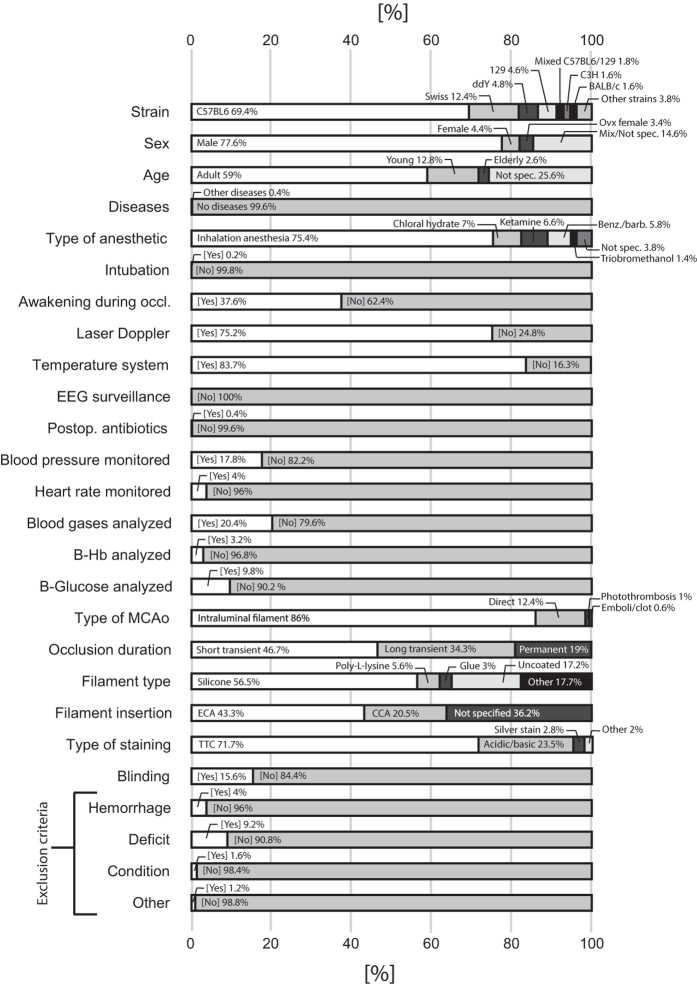
Frequencies of registered categories in the 500 control groups.The figure also includes variables that were omitted from statistical
analysis due to too few articles providing these data. Some variable names
are abbreviated, see Table 1 for extended
descriptions. EEG = Electroencephalography;
B = Blood; MCAo = Middle
cerebral artery occlusion; TTC = Triphenyl
tetrazolium chloride; ECA = External carotid artery;
CCA = Common carotid artery.